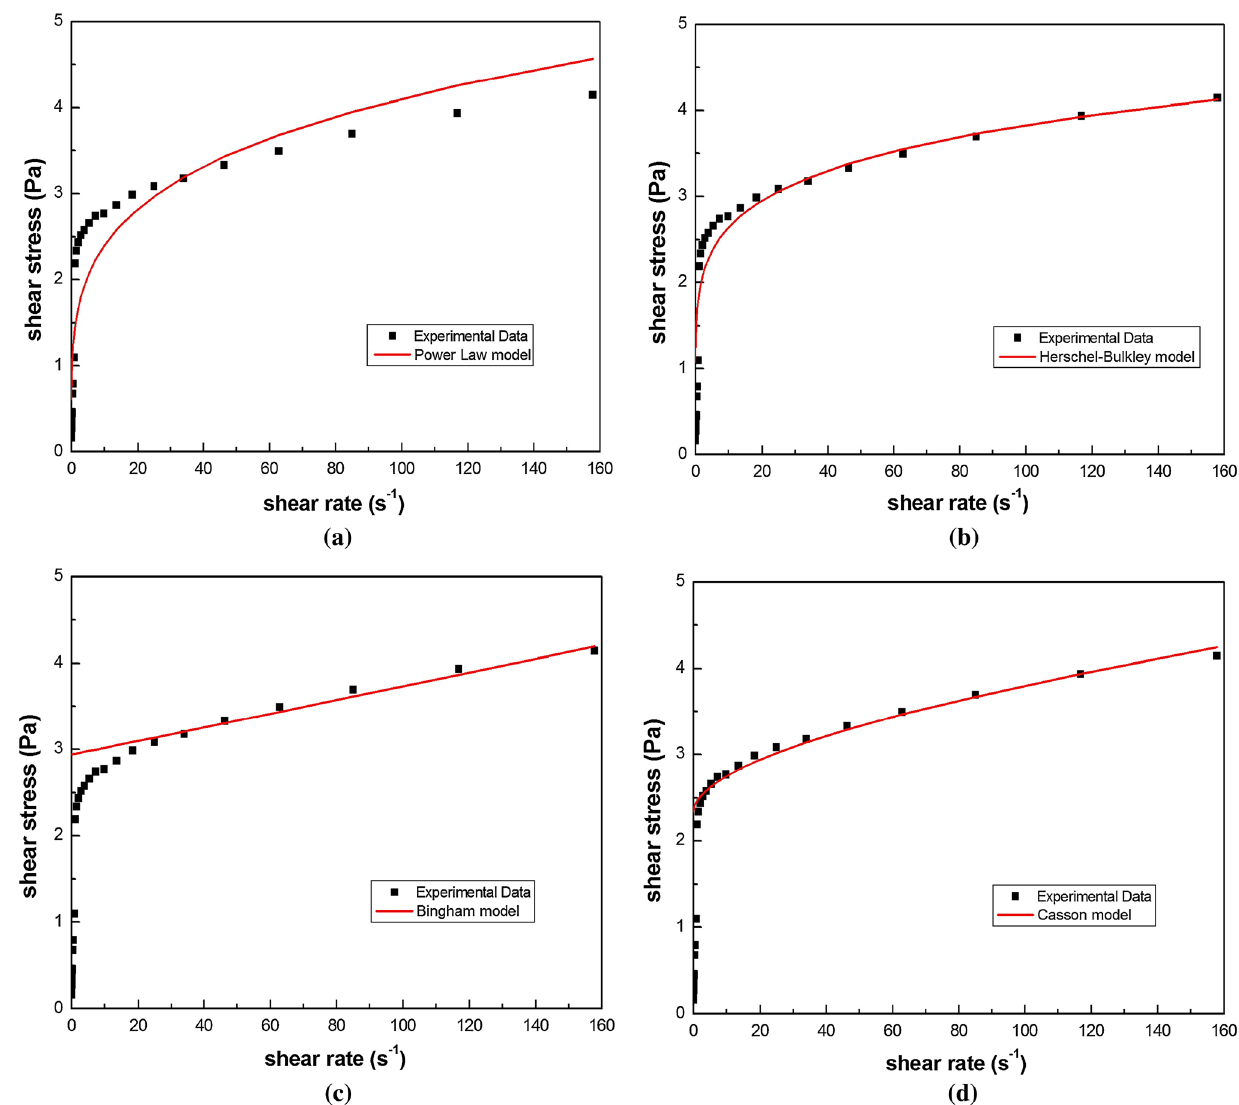
k = 1.6741; n = 0.1700; R 2 = 0.9014 ). c Bing- fitting ( 𝜏 0 = 0.1656; s = 32.5% and R 2 = 0.4708 ham model fitting ( 𝜏 0 = 2.9388; 𝜇 B = 0.0079; ). d Casson R 2 = 0.6788 model fitting ( 𝜏 0 = 2.3195; 𝜇 0 = 0.00182 ) 2 ,